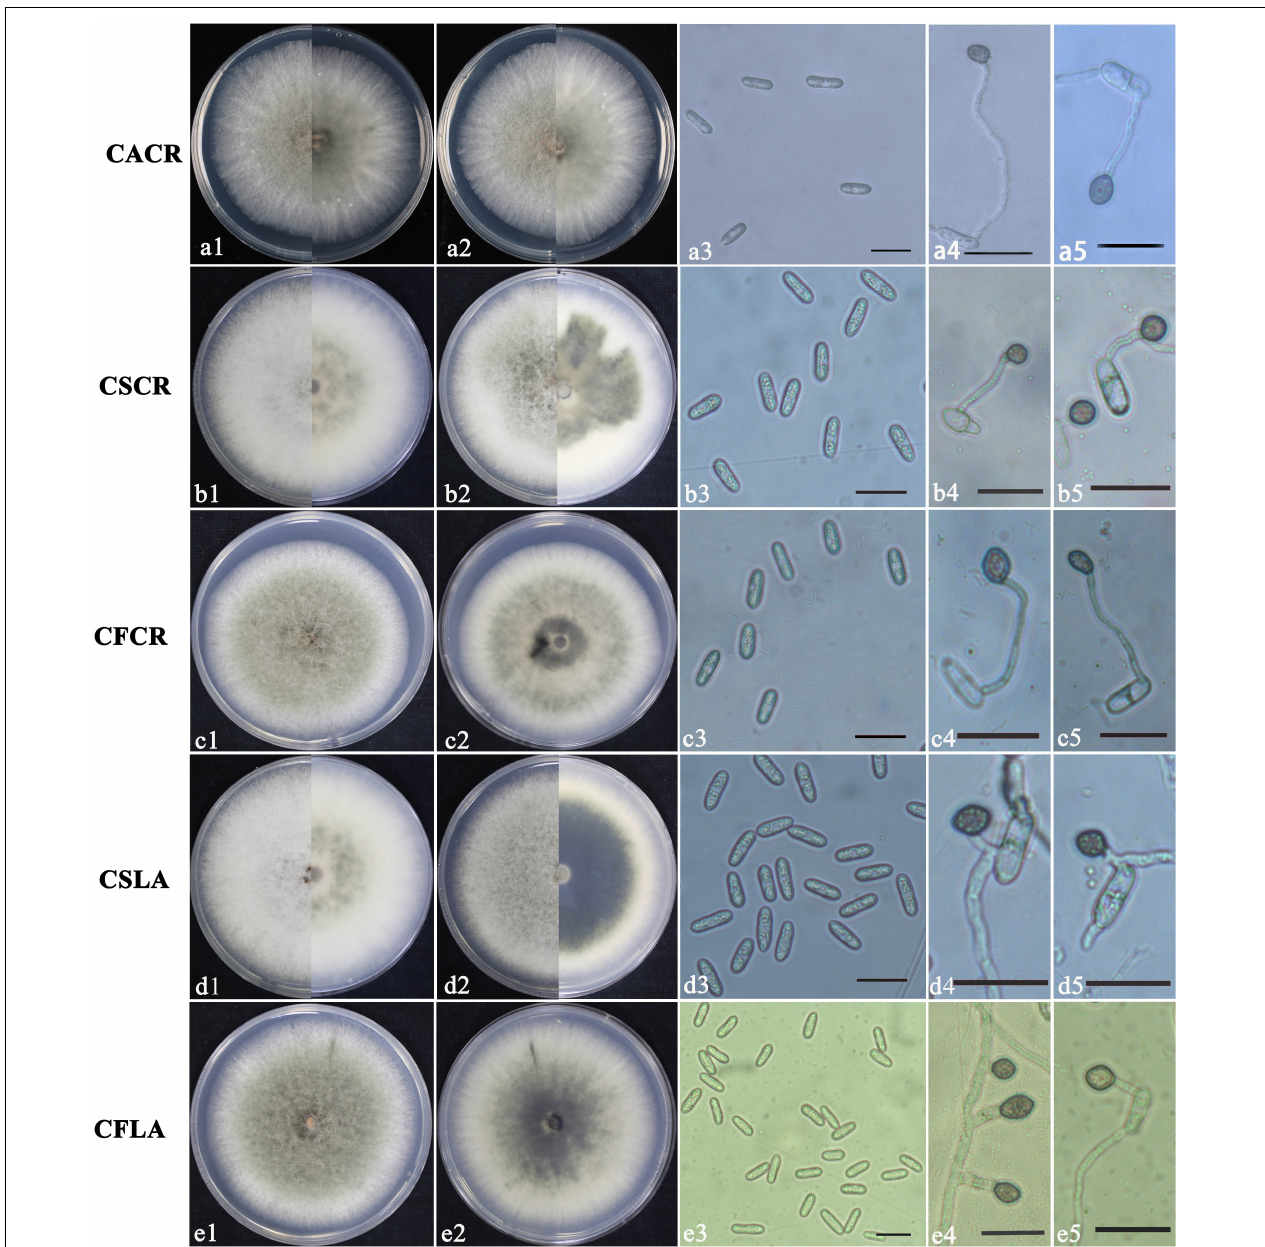
FIGURE 1 | Colony morphology of CACR ( Colletotrichum aenigma causing crown rot), CSCR ( C. siamense causing crown rot), CSLA ( C. siamense causing leaf anthracnose), CFCR (C. fructicola causing crown rot) and CFLA ( C. fructicola causing leaf anthracnose) on PDA (a1–e1,a2–e2) , conidia (a3–e3) and appressoria (a4–e4,a5–e5) , scale bar in 3 = 20 µ m in (a3–e3 , a4–e4 , a5–e5) .